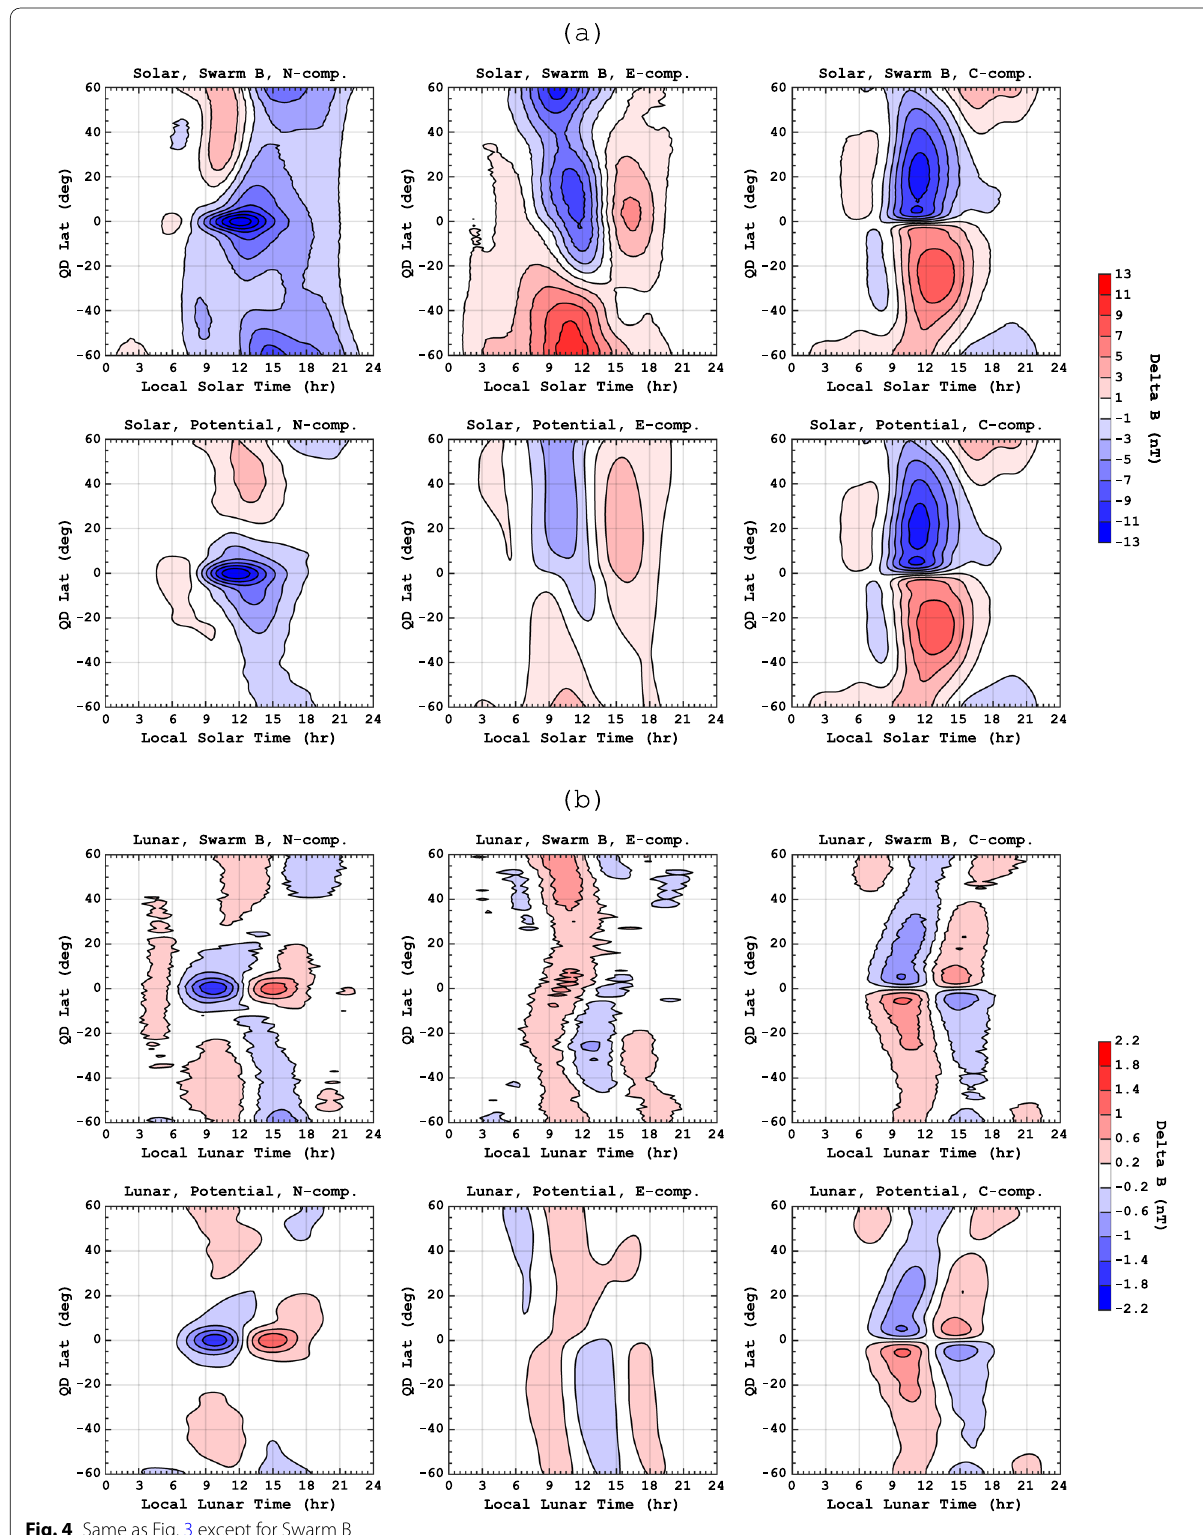
Fig. 4 Same as Fig. 3 except for Swarm